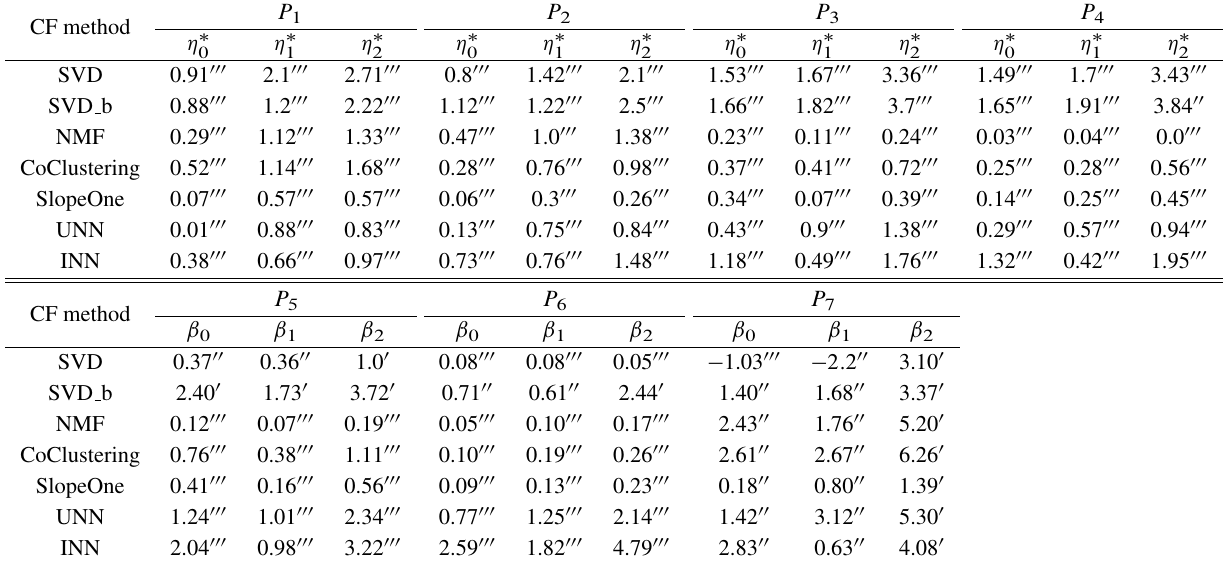
Table 5 Results of regression analysis of AL using model in Eq. (15).